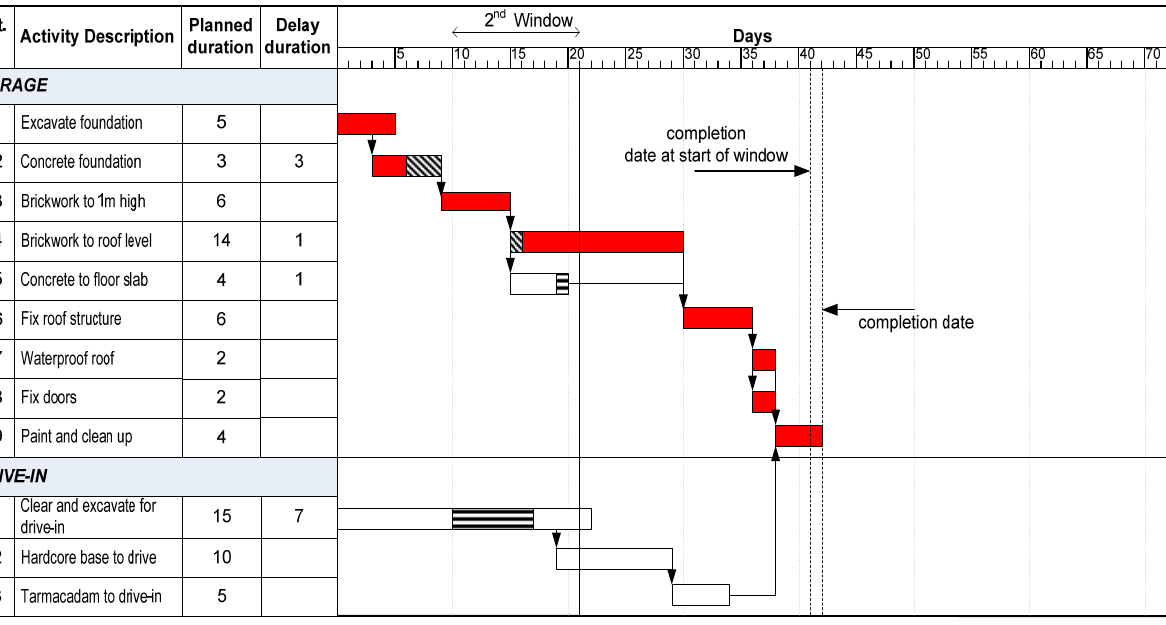
Figure 19. Updated schedule on day 21.